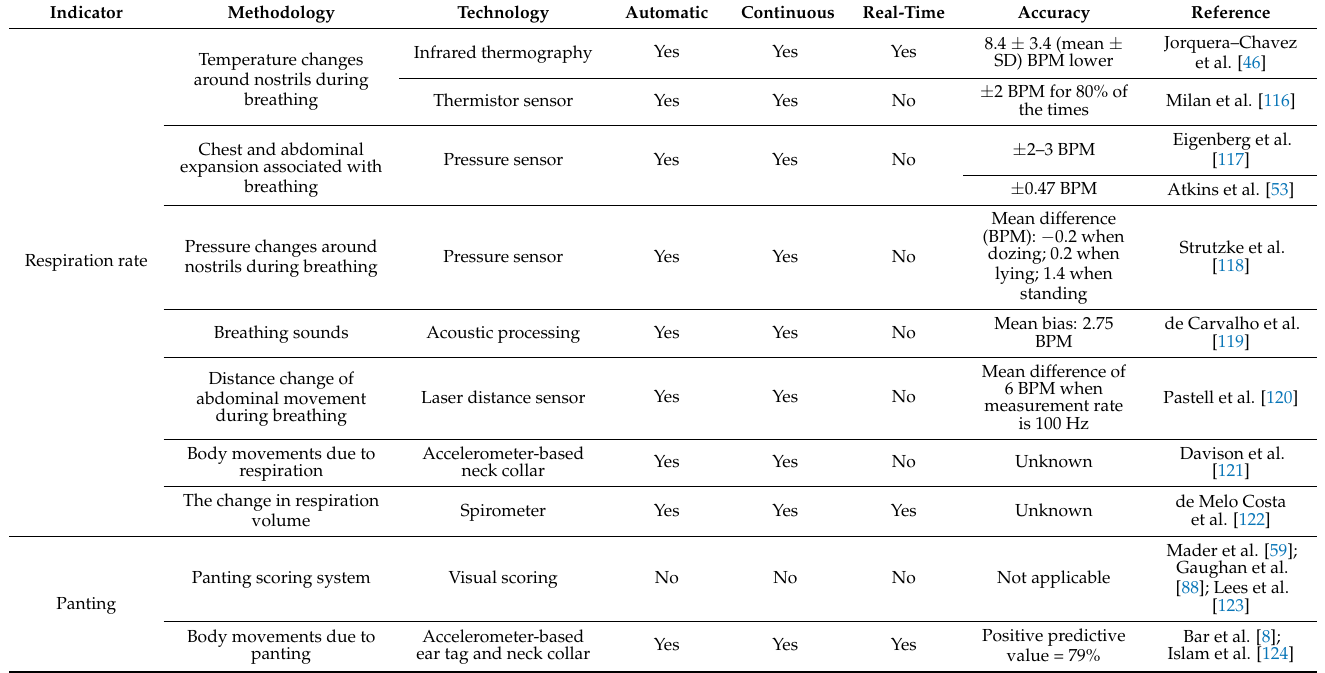
Table 3. Summary of the state-of-the-art measurement methods for respiration-related data.